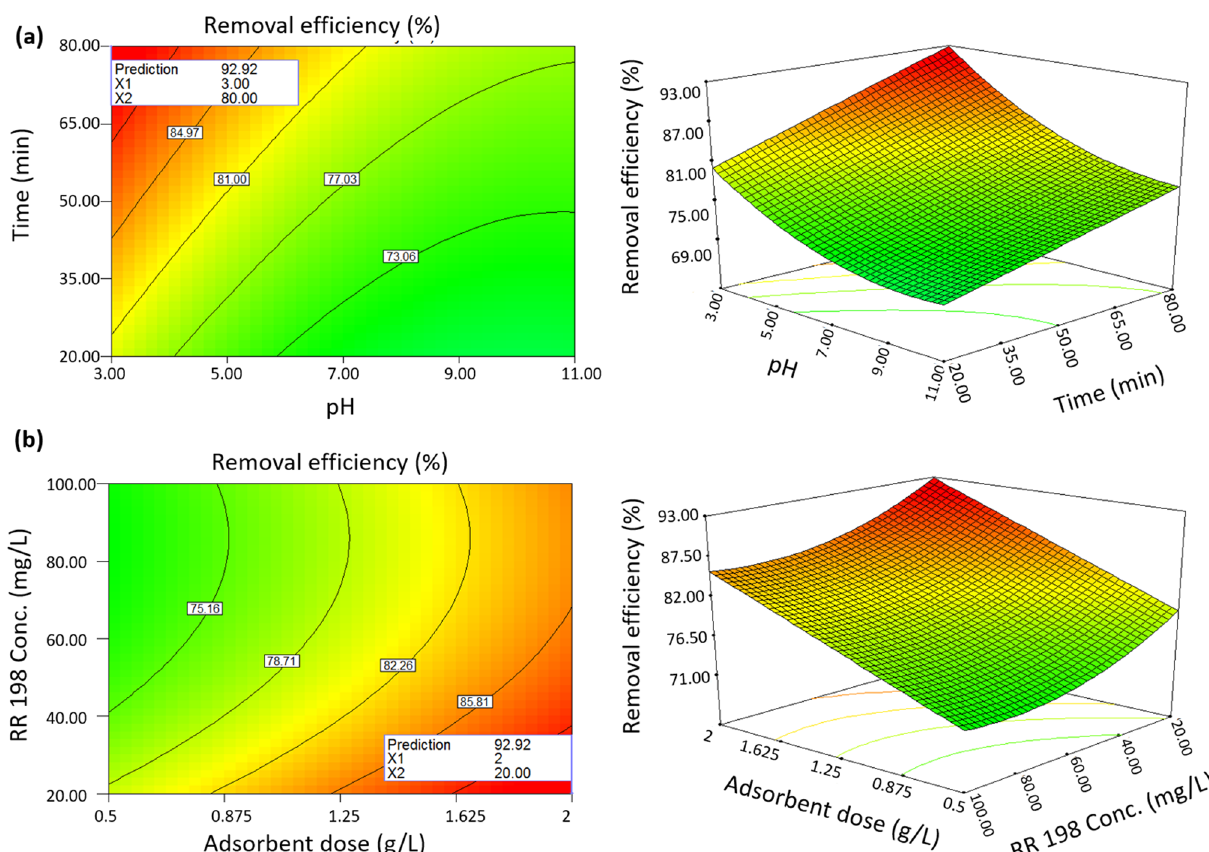
Figure 6. 3D response surface plot and contour plot of the absorption of RR198 onto MSW compost ash as a function of pH versus time ( a ) and adsorbent dose versus RR198 Con. ( b